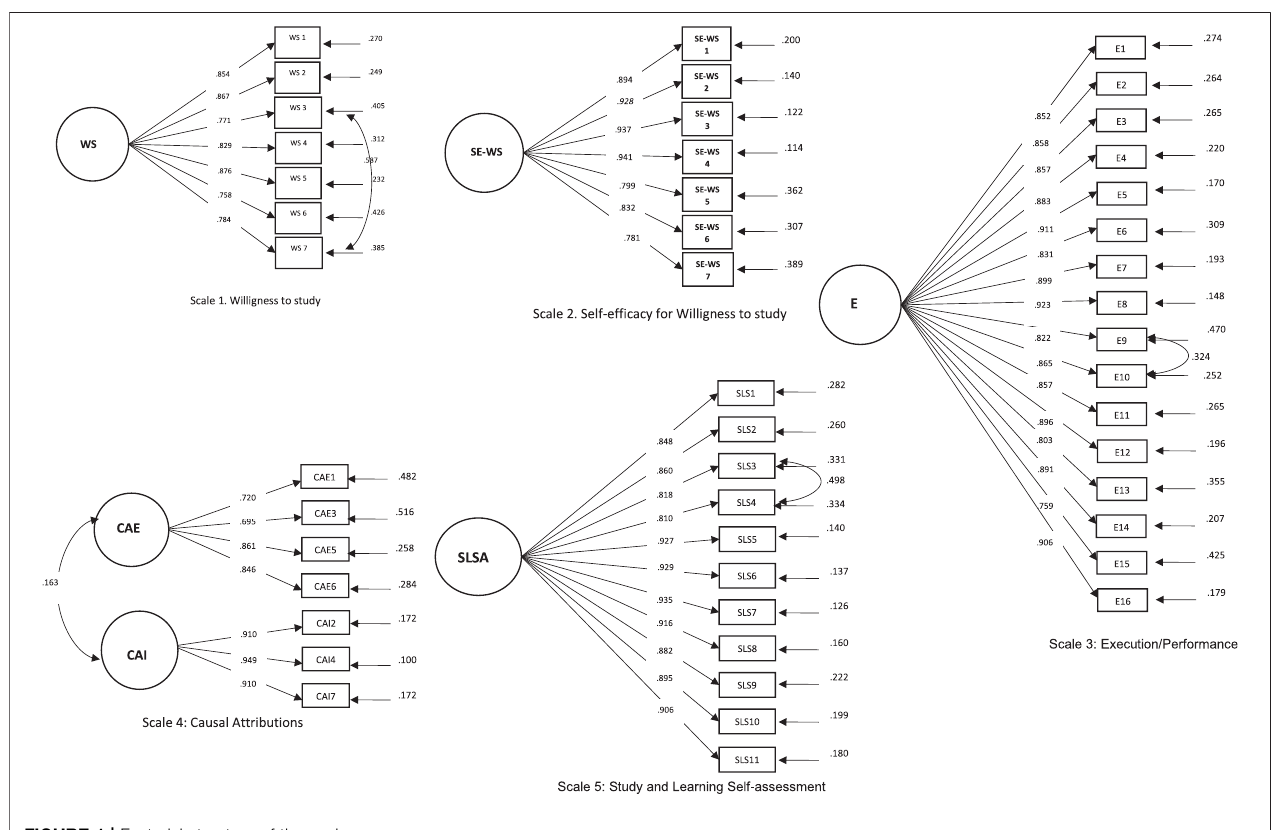
FIGURE 1 | Factorial structure of the